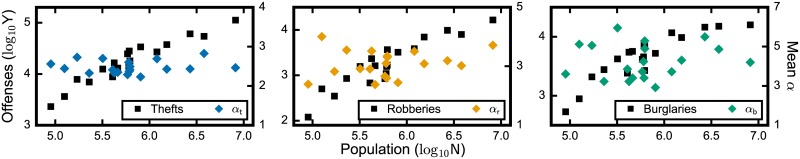
The size of the city lacks influence on the level of crime concentration.Though the growth of a city implies an increase in crime rates, the spatial concentration of offenses seems to be independent of the population size of the city. To test this, we employed Hoeffding’s independence test from which we could not reject the hypothesis that population size and the exponent of the power-law fit of the crime distribution are independent. In the case of thefts, the well-behaved α exponent suggests scale invariance, while robberies and burglaries seem to be more sensible to the cities, albeit uncorrelated with city size. In the double-y-axes plots, squares indicate the total number of offenses in a city during a year; while diamonds represent the average power-law exponent for a city.